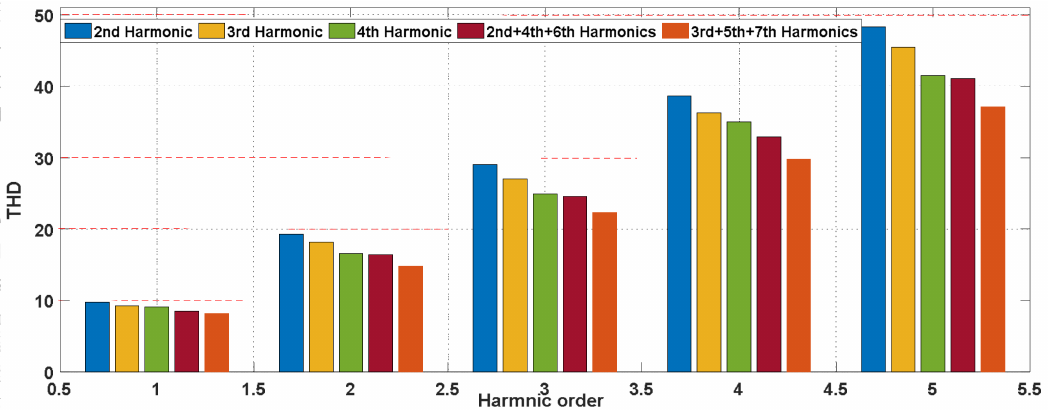
Figure 14. Commercial relay measurement of